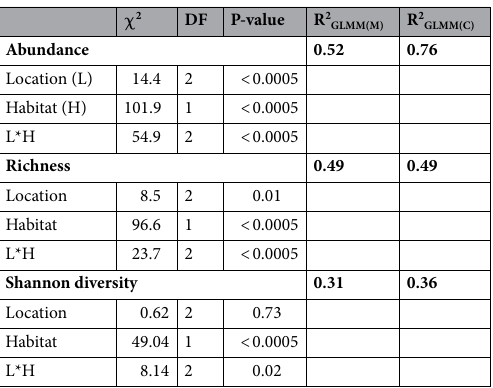
Table 1. Results of generalized linear mixed effect models for dung beetle abundance, richness, and diversity. The effect types are location, habitat, and an interaction between location and habitat. R 2 marginal denotes the proportion of variance explained by the fixed effect; R 2 conditional denotes the proportion of variance explained by both the fixed and random